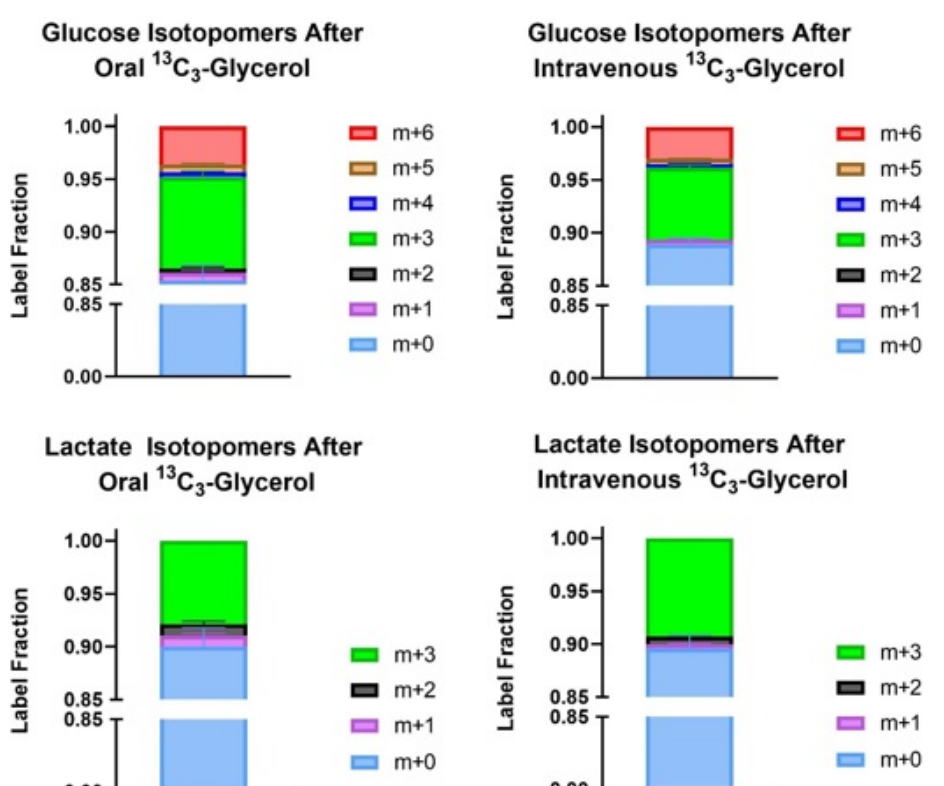
Figure 3. Isotopomer distribution of carbon-labeled glucose and lactate during peak enrichment of each metabolite after 13 C 3 -glycerol administration. n = 8.